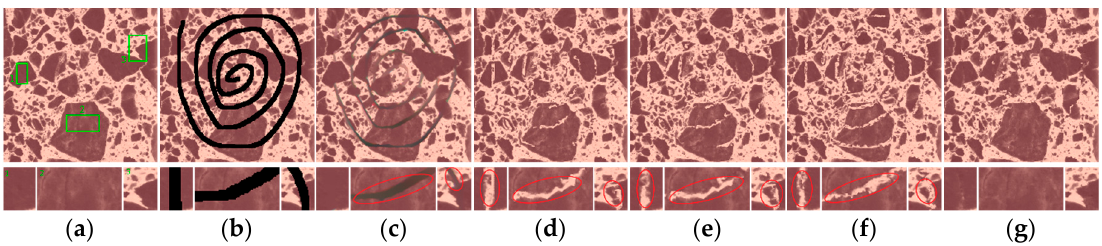
Figure 9. Comparison of inpainting results for Sculpture (256 × 256): ( a ) Ground truth; ( b ) incomplete image; ( c ) CDD model [4]; ( d ) Criminisi’s method [10]; ( e ) Liu’s method [17]; ( f ) Zhou’s method [18]; ( g ) proposed method.